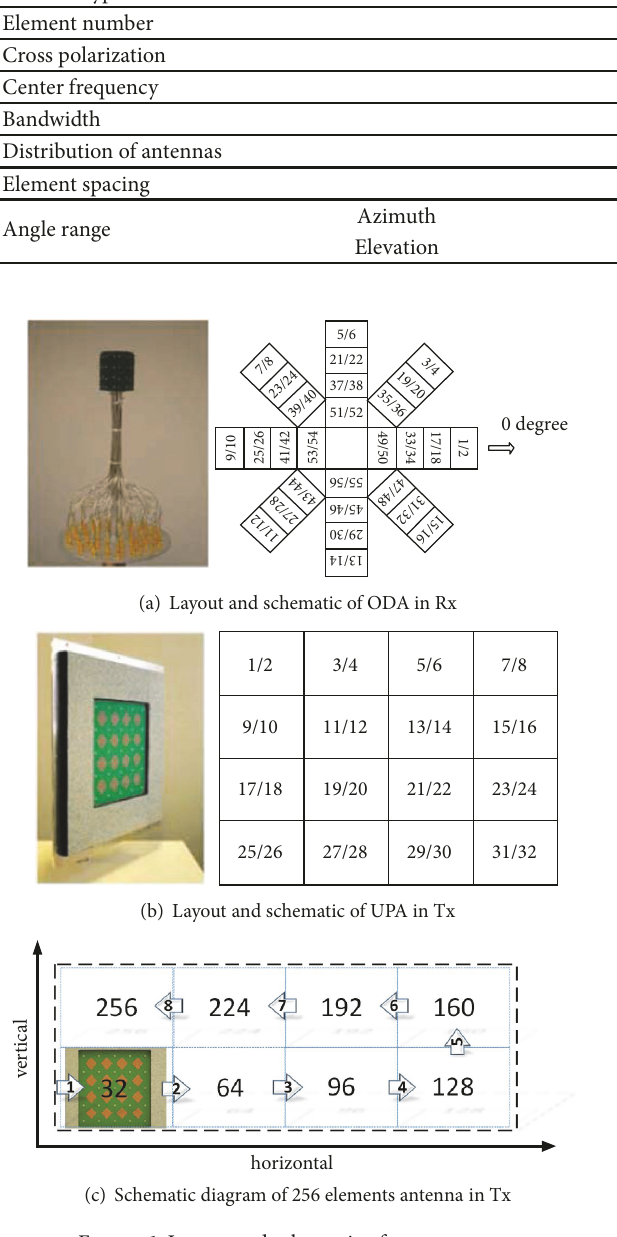
Figure 1: Layout and schematic of antenna